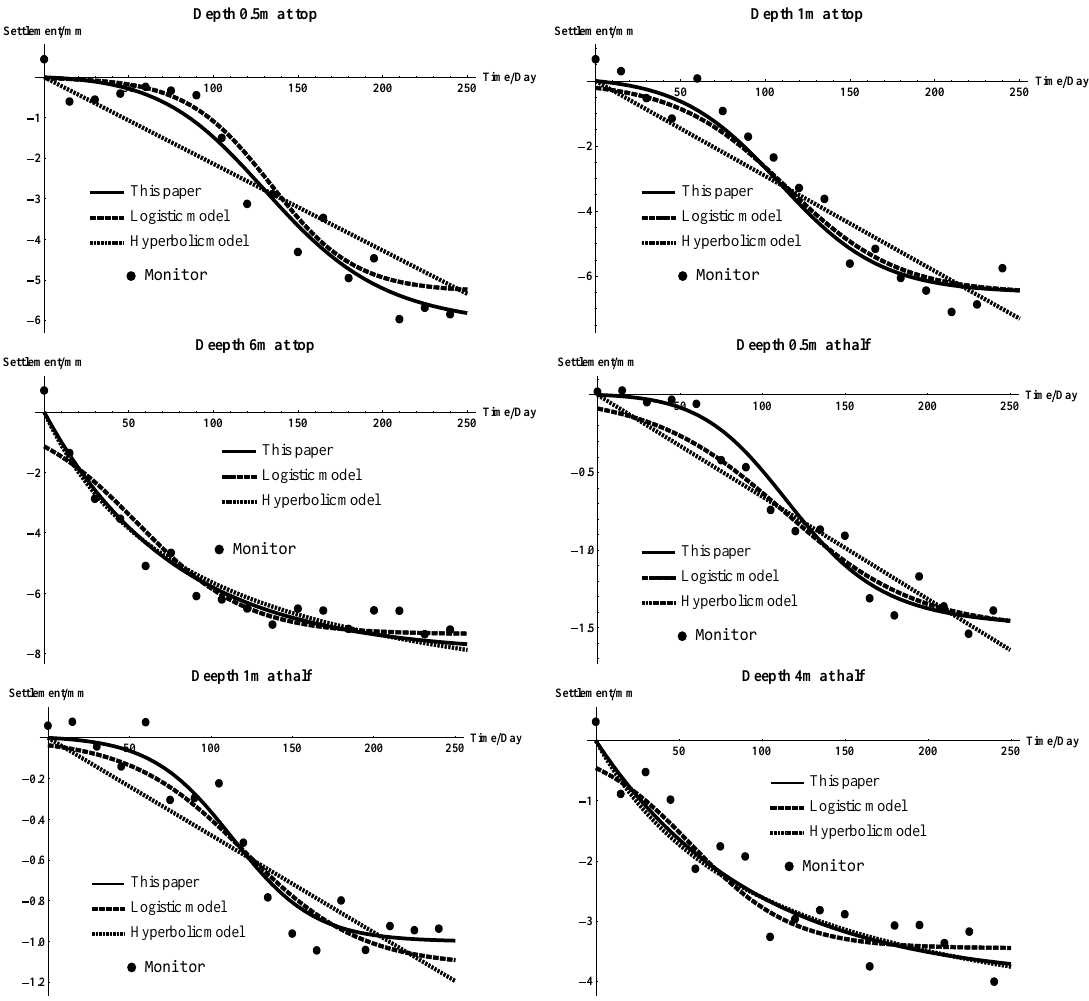
Figure 12. Settlement–time curve for internal settlement.